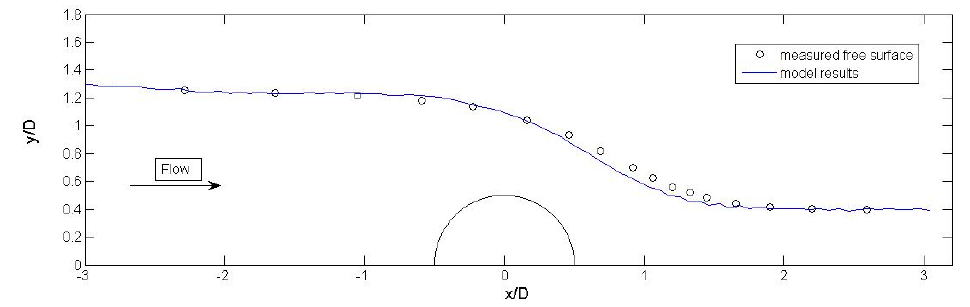
Figure 12. The calculated free surface profile result of the half-circular cylinder case.